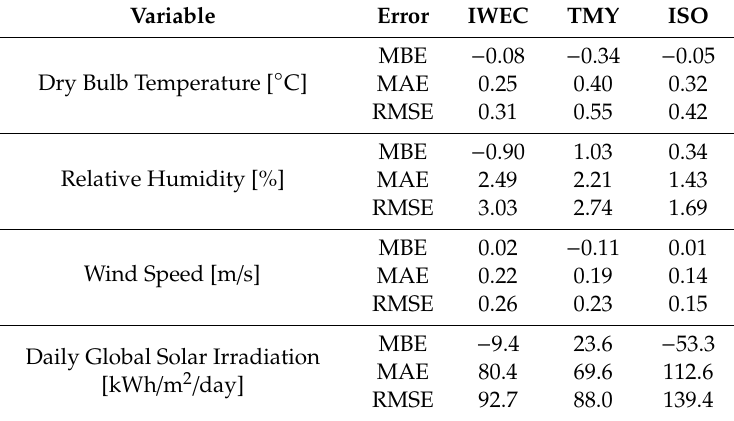
Table 7. Mean discrepancy between the typical years and the long-term average values for the measured weather parameters.